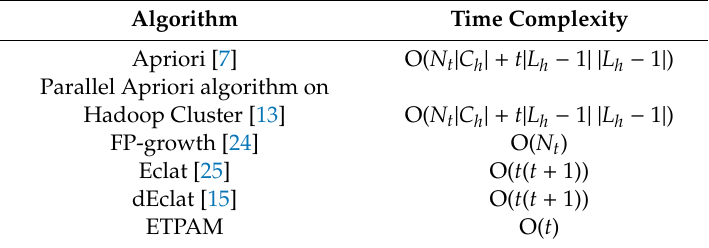
Table 2. Time complexities of some pattern mining